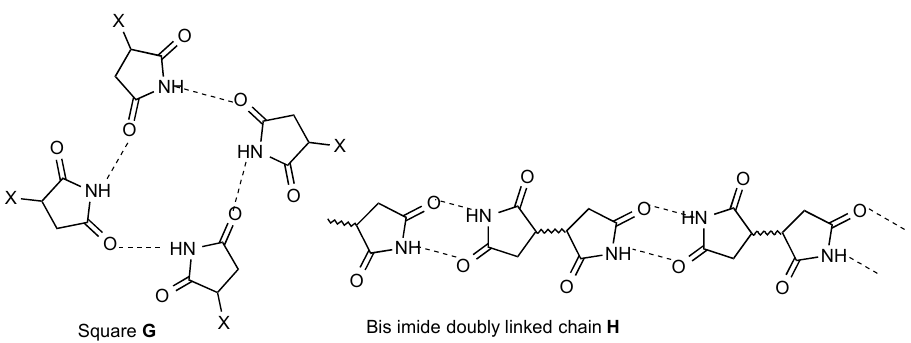
Figure 1. The most commonly observed hydrogen bonding patterns.